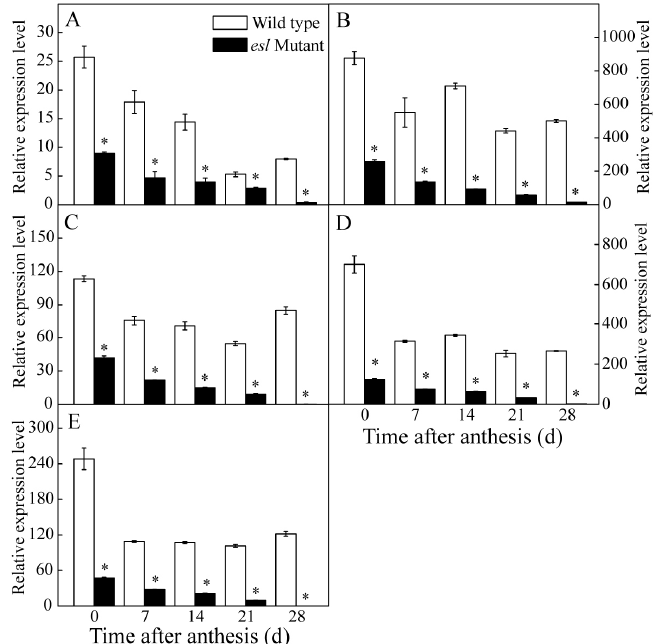
Figure 6. Comparison of the temporal expression patterns of ( A ) light-harvesting Chl a / b binding protein ( Cab) , ( B ) photosystem II binding protein A (PsbA ), ( C ) PsbB , ( D ) PsbC , and ( E ) PsbD in the flag leaves between the two rice genotypes during the grain-filling stage. Vertical bars represent standard errors ( n = 3). The asterisks represent significant differences between the esl mutant and its wild-type cultivar (* p < 0.05).